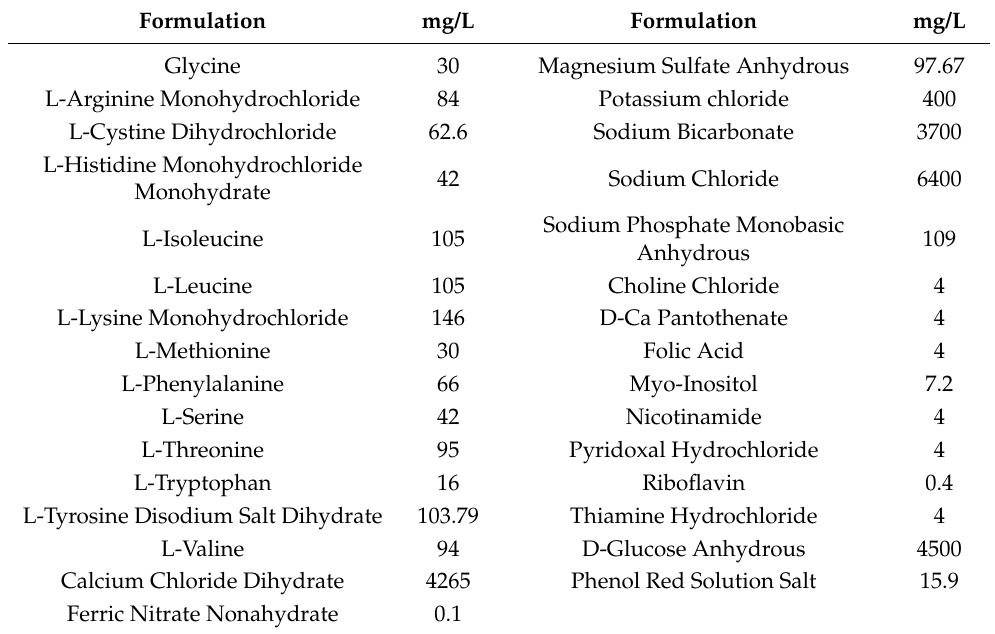
Table 2. Composition of DMEM